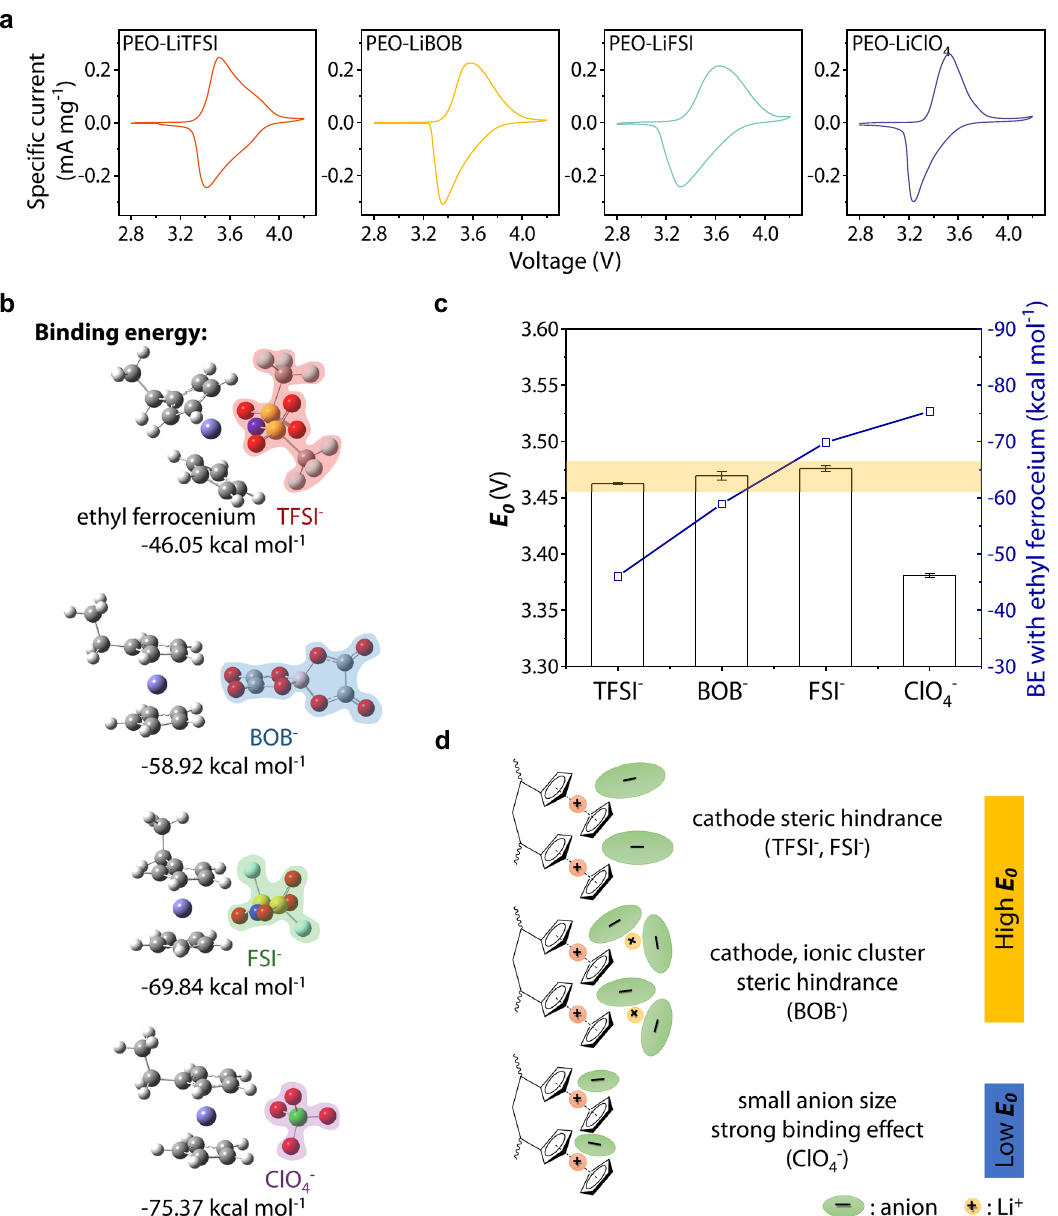
Fig. 4 Effect of the salt anion on the PVF electrode reactions. a Cyclic voltammetry curves of Li||PVF full cells constructed with different SPEs, performed at 0.2 mV s − 1 , 60 °C. b The anions binding energy with ethyl ferrocenium. c The electrode potential ( E 0 ) of SPEs, while E 0 is obtained by the mean of reduction and oxidation peaks in CVs (seen in Supplementary Table 5). Error bars represent the standard deviation calculated by the data sets. d The binding state of different anions to